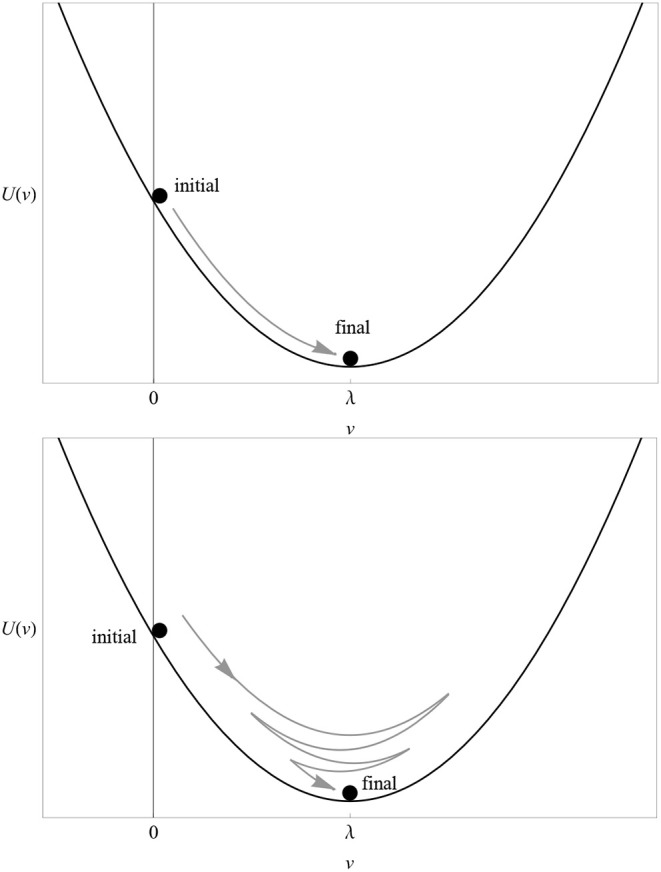
(Top) The potential U(v) of the RW model for λ = 1 and αβ = 1. Compare with the solution (3) in Figure 1. (Bottom) The potential U(v) of the dynamical model for λ = 1 and (αβ)2+μ2 = 1. Compare with the solution (8) in Figure 6. In both cases, the particle rolling down the potential represents the change in the associative strength. The direction of “motion” in excitatory conditioning is represented by a gray arrow.